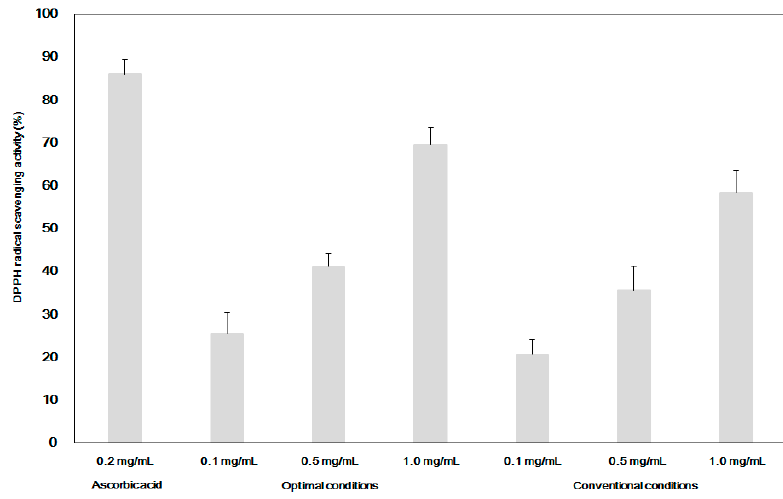
Figure 5. The α , α -diphenyl- β -picrylhydrazyl (DPPH) radical scavenging activity of the extracts from the optimal extraction conditions and a conventional extraction process.